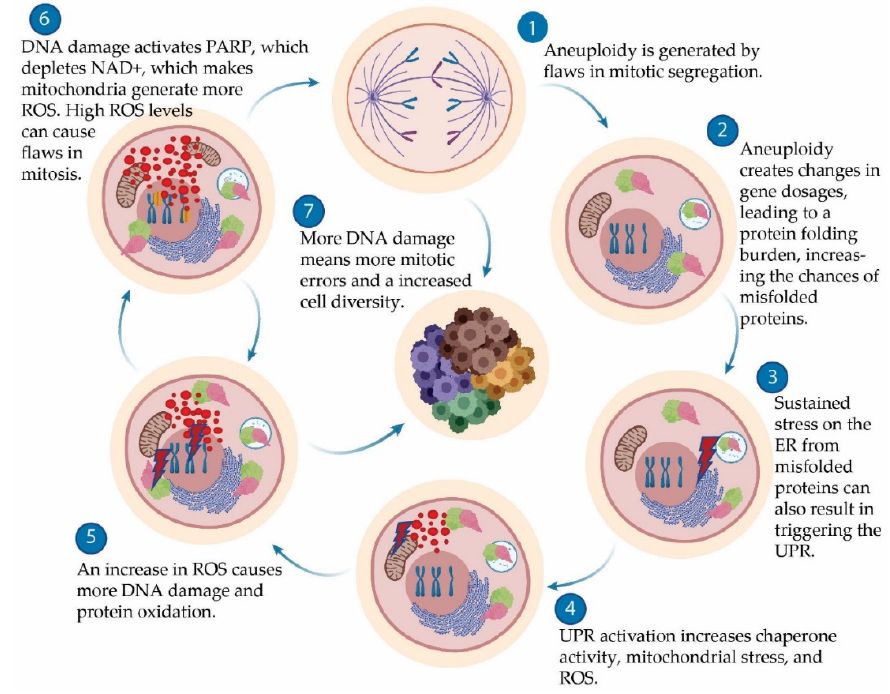
Figure 2. Overview of chromosomal instability (CIN) e ff ects on metabolism. ( 1 ) The onset of aneuploidy brings about several cellular consequences including ( 2 ) proteomic imbalances [50], which can lead to ( 3 ) endoplasmic reticulum (ER) stress and activation of unfolded protein response (UPR) mechanisms [89]. This leads to ( 4 ) increased mitochondrial activity due to increased energy demands and ROS production, which brings about ( 5 ) more DNA damage and protein oxidation. These lead to stress and damage to mitochondria, the ER and DNA. ( 6 ) DNA damage is repaired by poly (ADP-ribose) polymerase (PARP) activity, which uses NAD + , putting more stress on mitochondria, which results in more ROS [81]. ( 7 ) More DNA damage results in more mitotic errors, which increases cellular